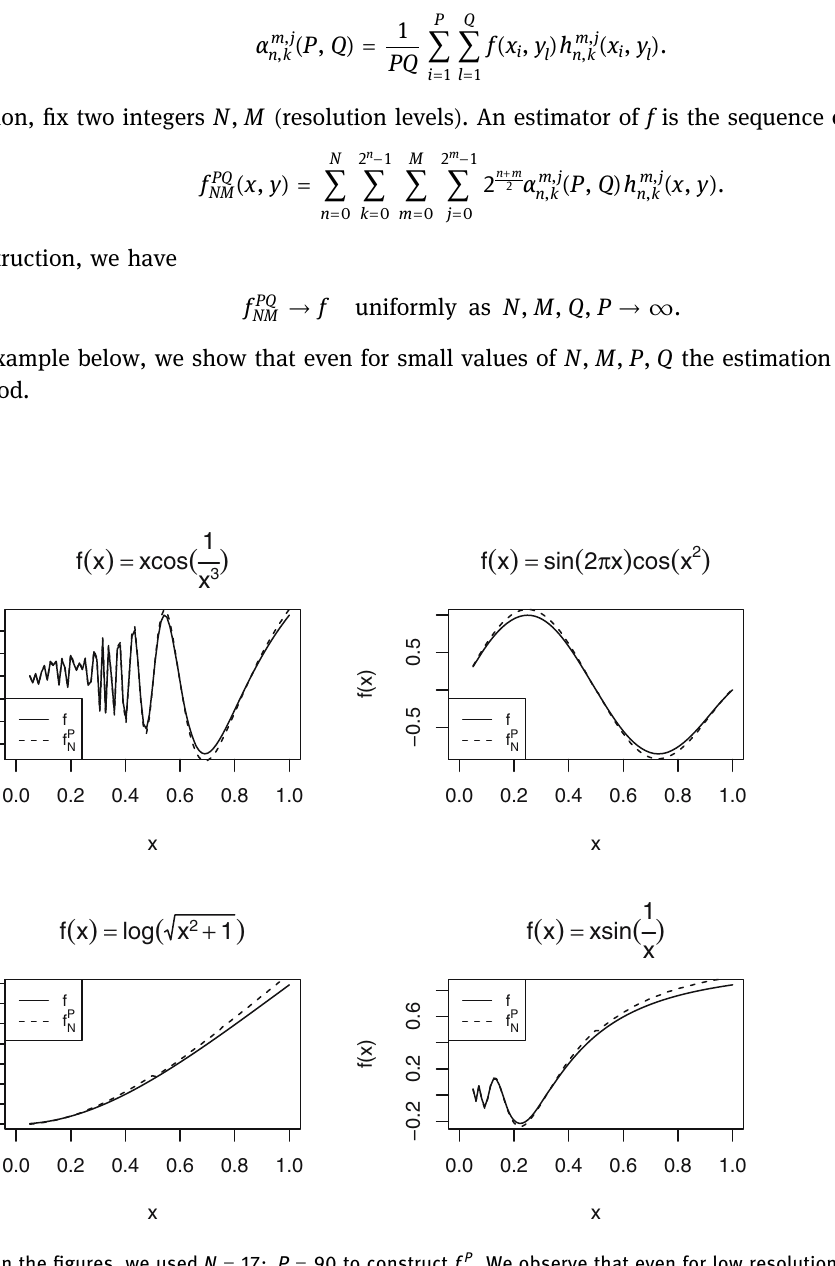
Figure 6: In the fi gures, we used = = N P 17; 90 to construct f NP . We observe that even for low resolution level and relatively small number of points, we obtain a good